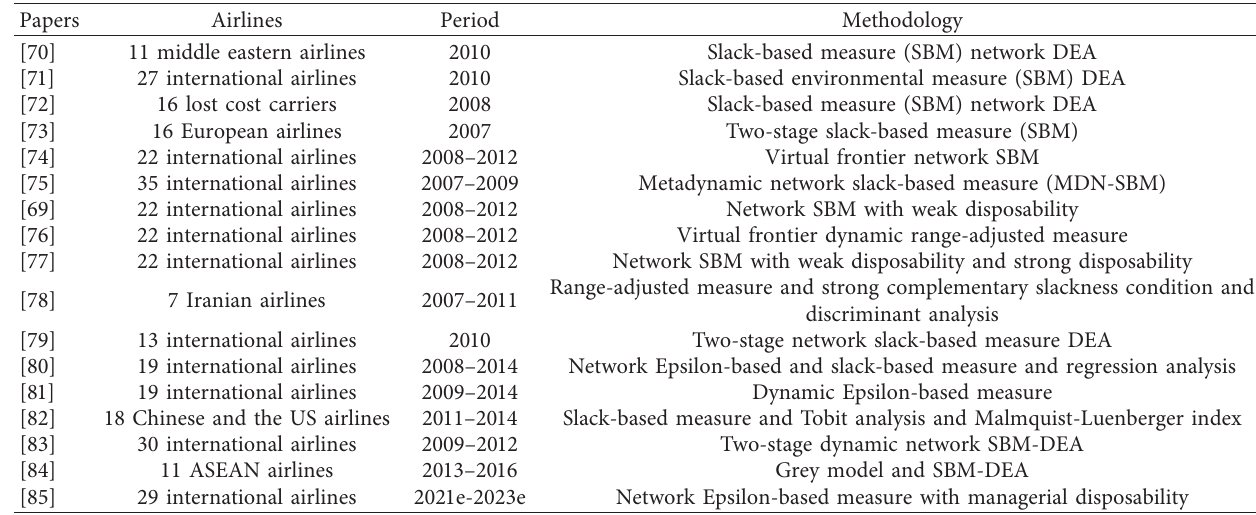
Table 4: Application of nonradial DEA and EBM in airline